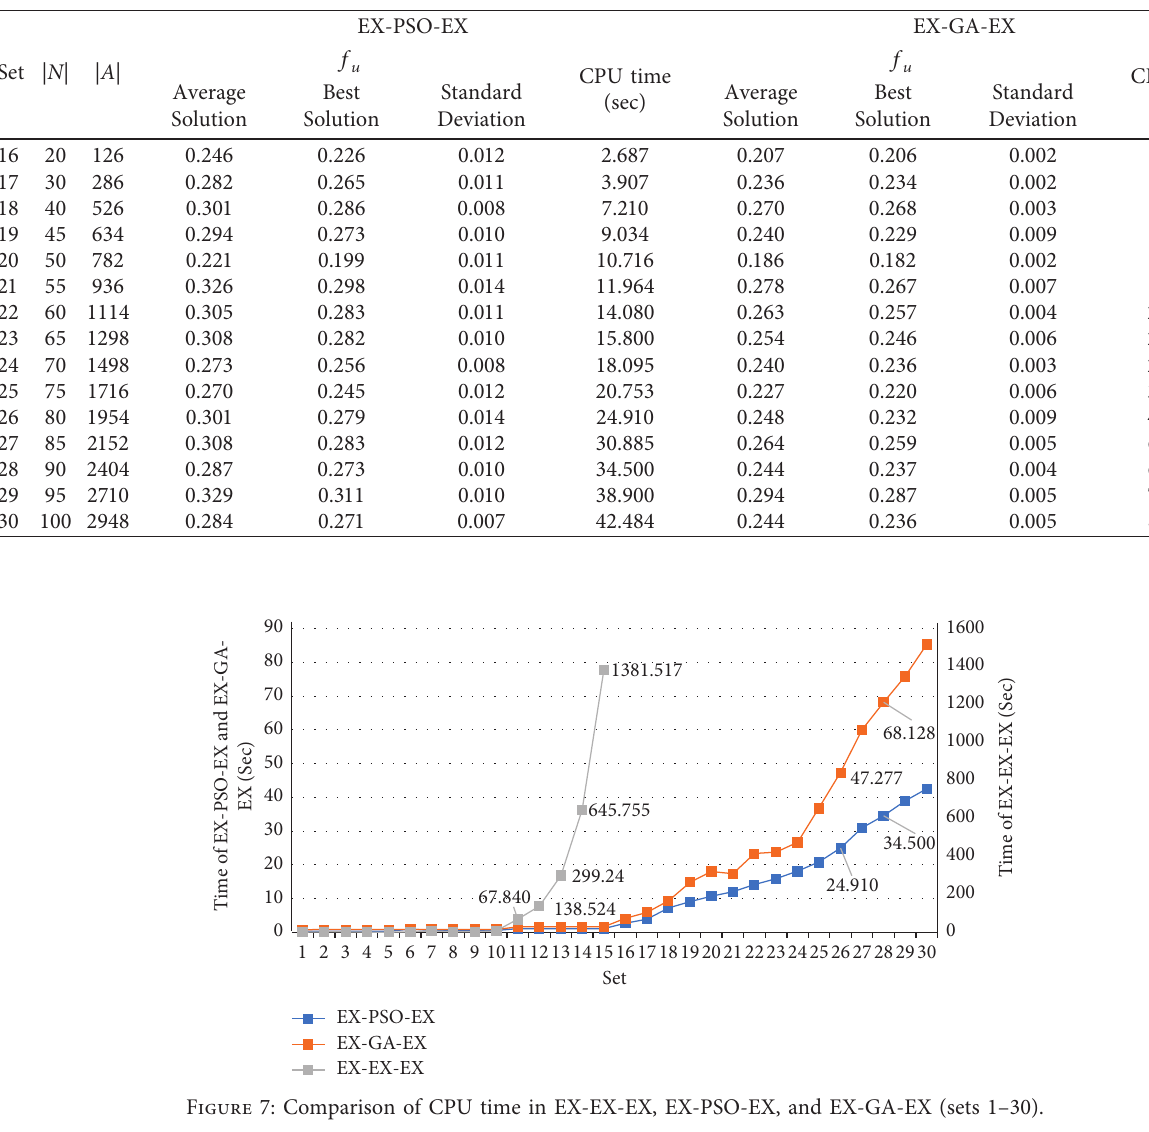
Table 7: Computational comparison of medium scale and large scale between EX-PSO-EX and EX-GA-EX with | W | � 20, α � 0.1, β � 0.1, and λ � 0.7 (sets 16–30).